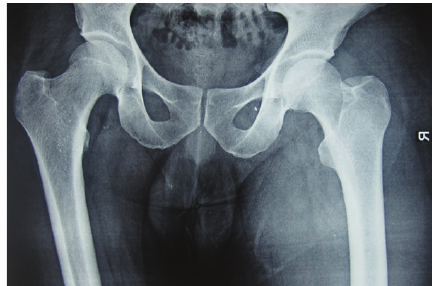
Figure 1: X-ray bilateral hip joint—X-ray showing a normal hip joint and femur with soft tissue swelling on right thigh.